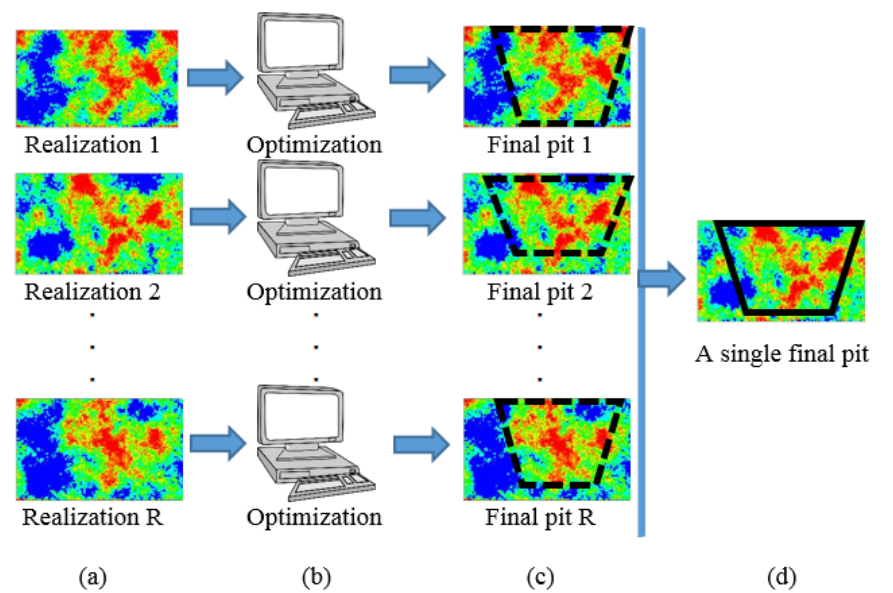
Figure 1. A first approach to compute final pit limit: ( a ) a set of realizations representing the geological uncertainty are used as input individually, ( b ) the optimization computes a final pit for each realization, ( c ) a set of partial solutions are given, and ( d ) applying some criteria, a single final pit limit is selected.